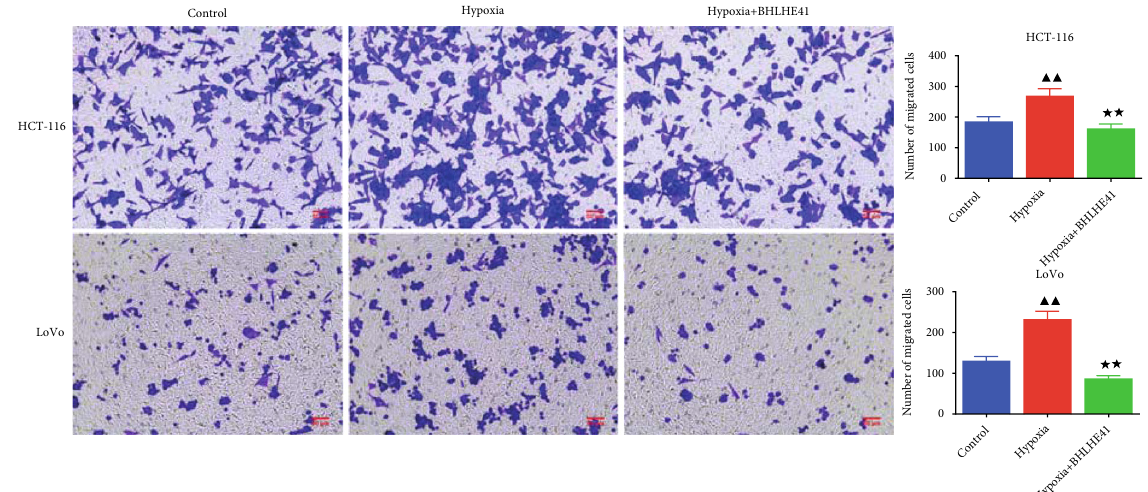
Figure 6: BHLHE41 overexpression repressed the migration in hypoxia-induced CC cells. The migration in hypoxia-induced CC cells was tested by Transwell assay. All experiments have been performed in triplicate, and data were expressed as mean ± SD . ∗∗ P < 0 : 01 vs. hypoxia; ▲▲ P < 0 : 01 vs. control.